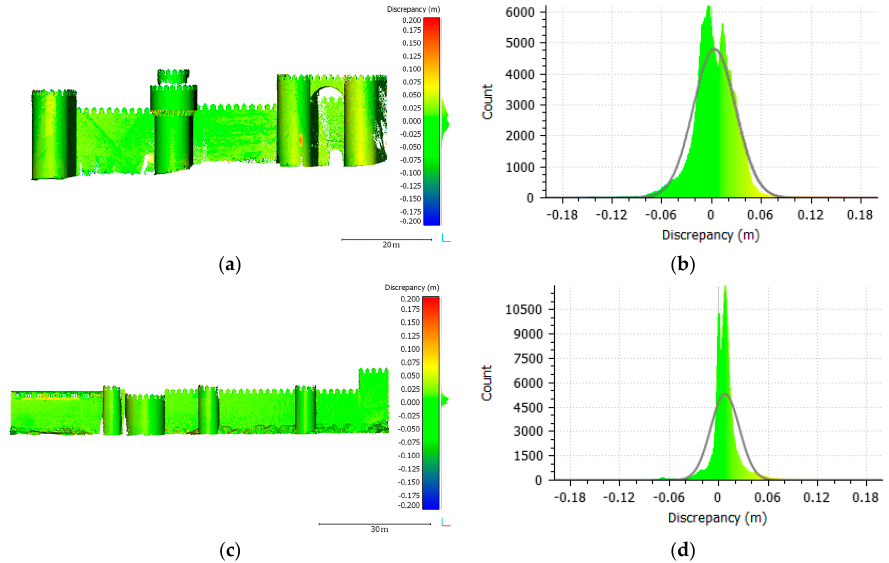
Figure 7. Relative discrepancies maps between MLS and TLS in the “Alcazar” fortress ( Left ) and its associated histogram ( Right ) for the: east walls ( a , b ); and south walls ( c , d ).